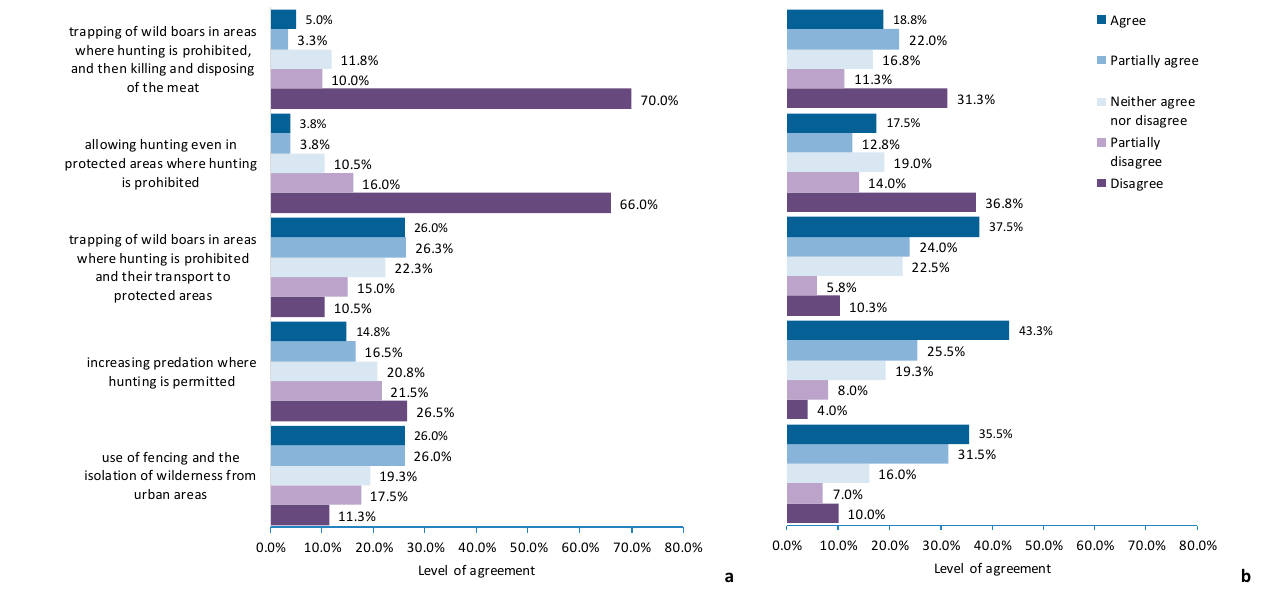
Figure 6. ( a , b ) The solution to the wild boar invasion according to the citizens of the urban area ( a ) and the rural area ( b ).